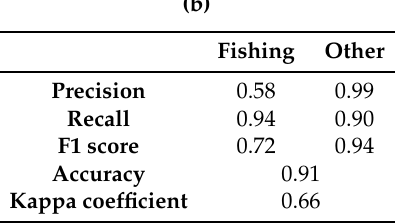
Table 4. Accuracy assessment using test sets composed of 12.6% of fishing samples and 87.4% of non-fishing